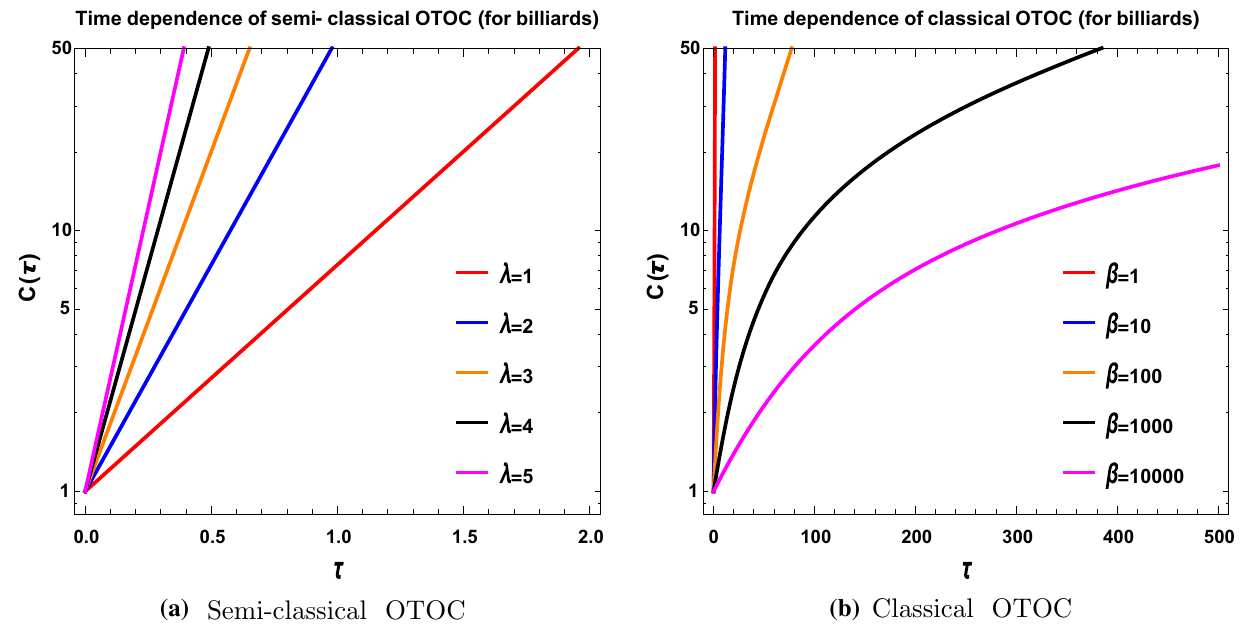
Fig. 21 Time dependent behaviour of semi-classical and classical OTOC for